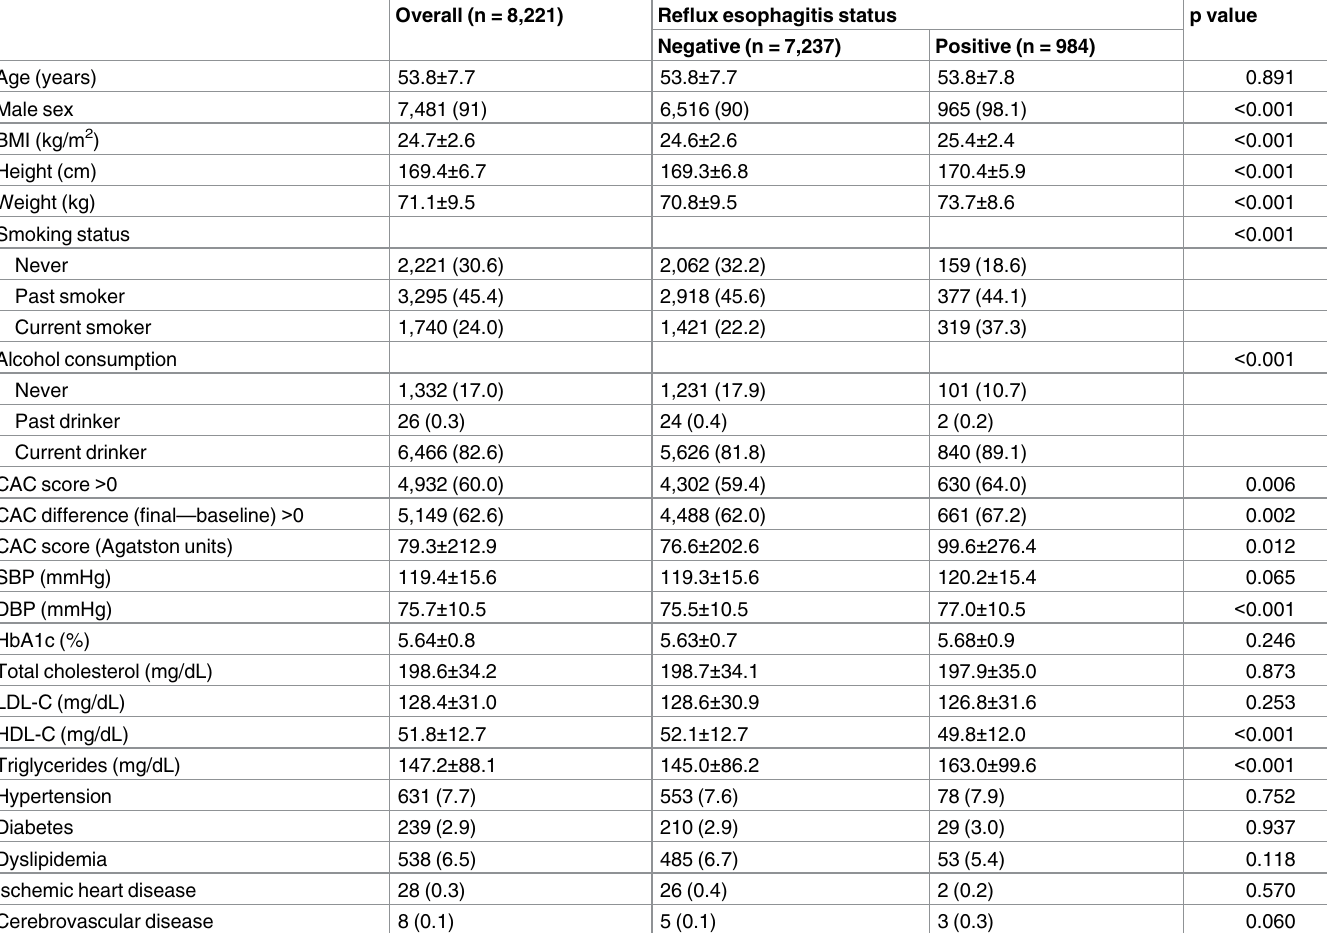
Table 2. Baseline characteristics of the study participants according to the reflux esophagitis